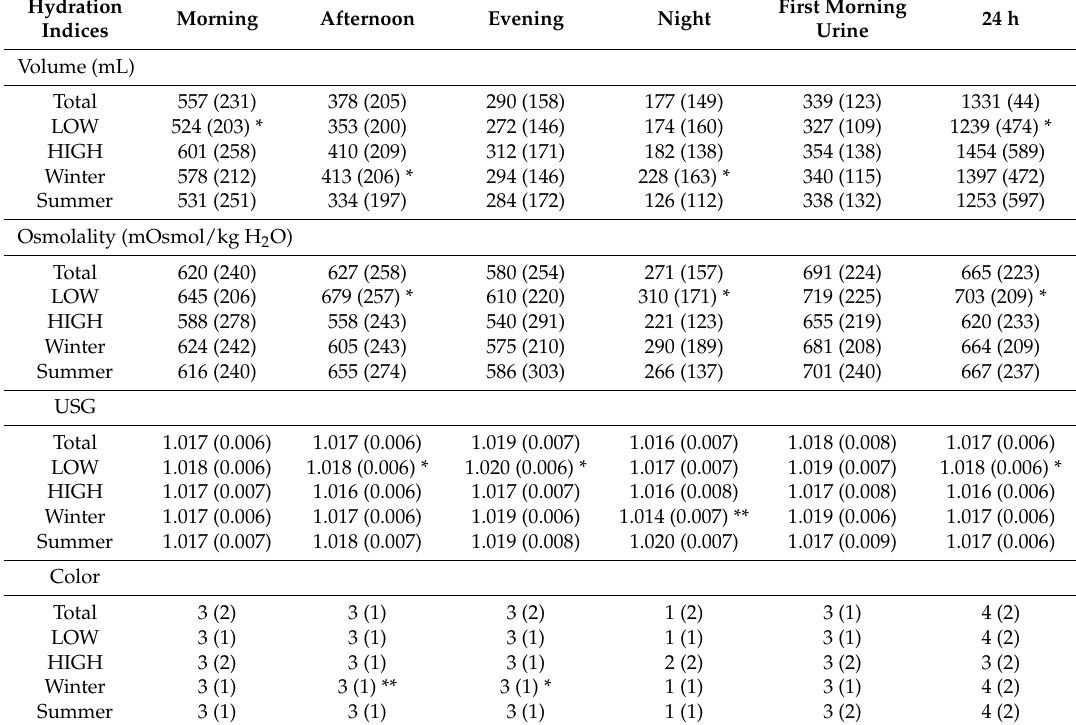
Table 2. Urine hydration indices of subjects in each 6 h period, in first morning, and 24 h samples for the total sample, LOW drinkers (subjects with a total water intake lower than EFSA dietary references), HIGH drinkers (subjects with a total water intake higher than EFSA dietary references), winter and summer